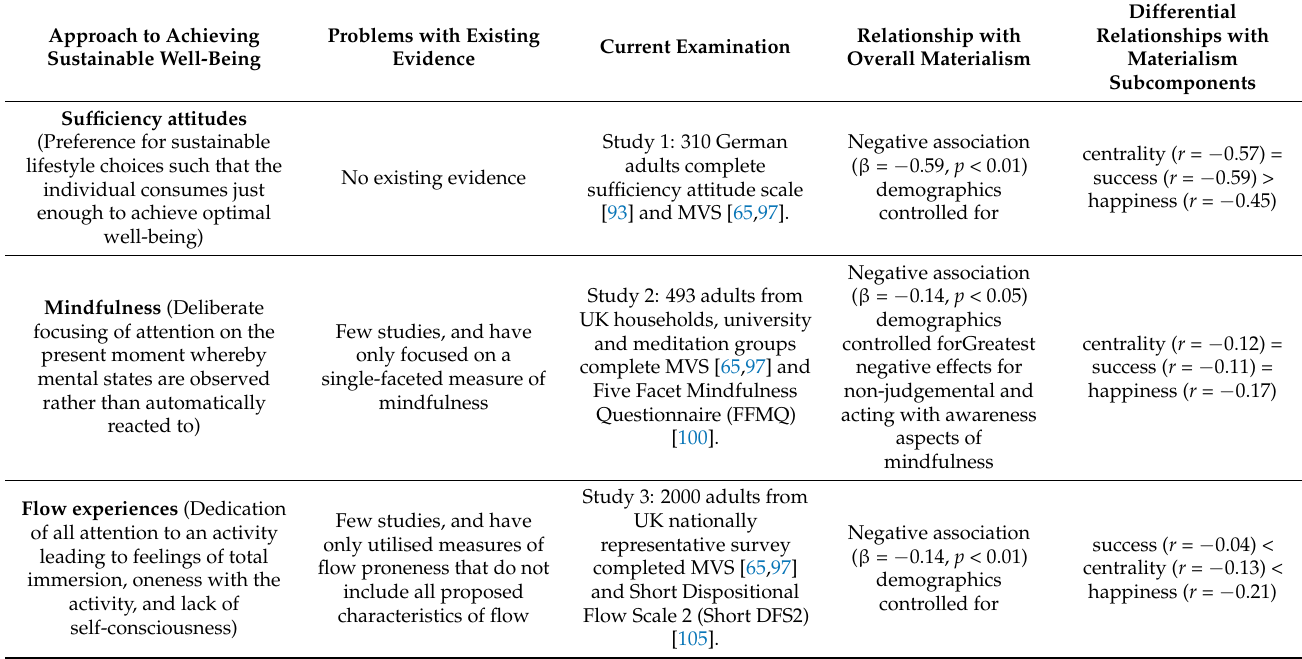
Table 7. Summary of empirical studies and